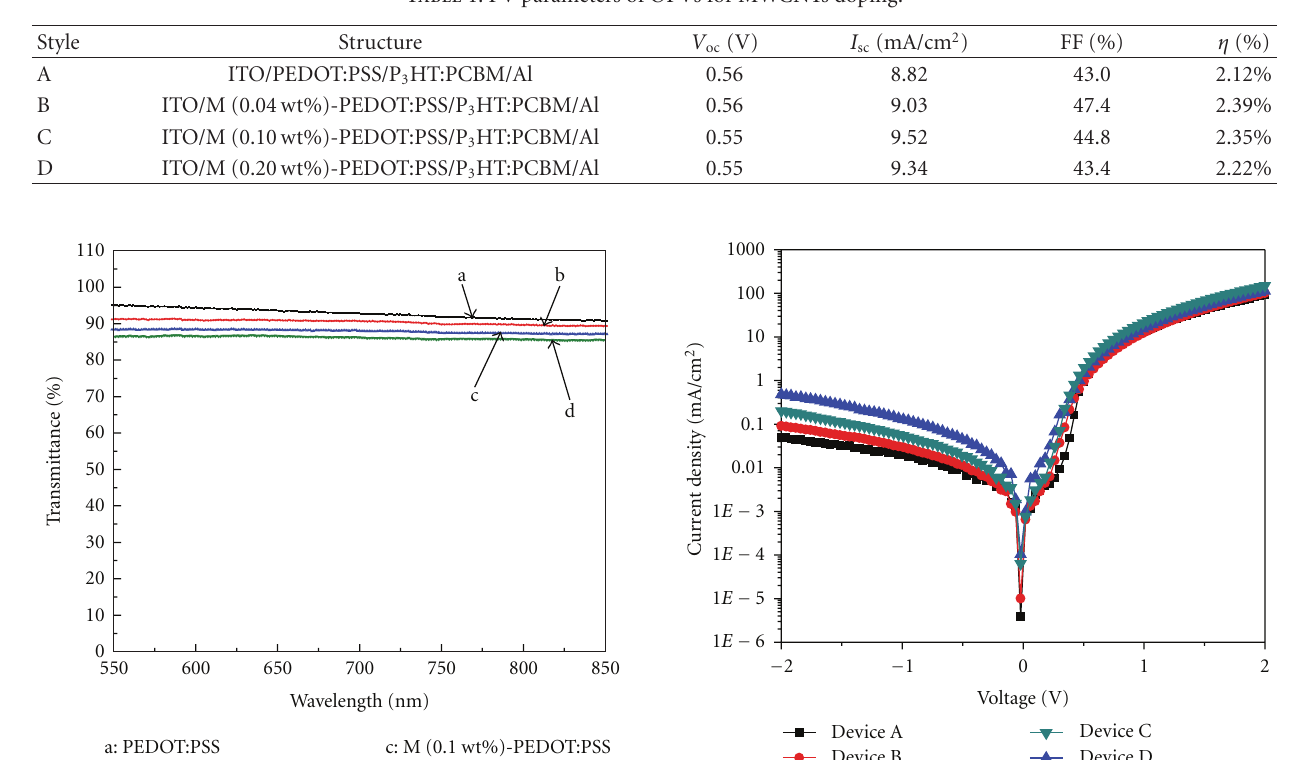
Figure 2: SEM of untreated and treated MWCNTs- (a) untreated MWCNTs; (b) treated MWCNTs Table 1: PV parameters of OPVs for MWCNTs doping.